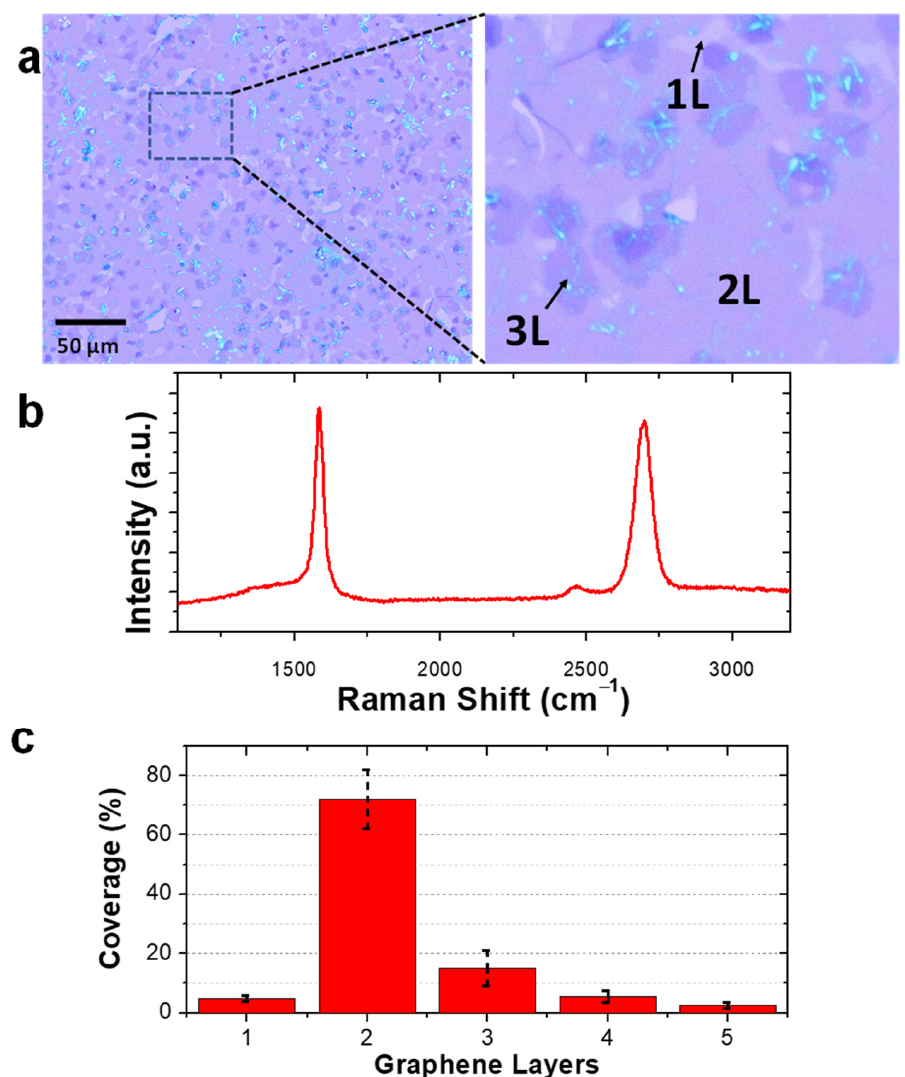
Figure 6. Large area bilayer graphene coverage demonstration ( a ) optical images with blow-up showing predominantly 2 L coverage with small islands of 1 L and 3 L domains, ( b ) plot of Raman spectra with I 2D/G ≅ 1 elucidating 2 L coverage, ( c ) bar graph showing ≥ 70% coverage of bilayer graphene growth with small amounts of monolayer and multilayer ( ≥ 3) domains.